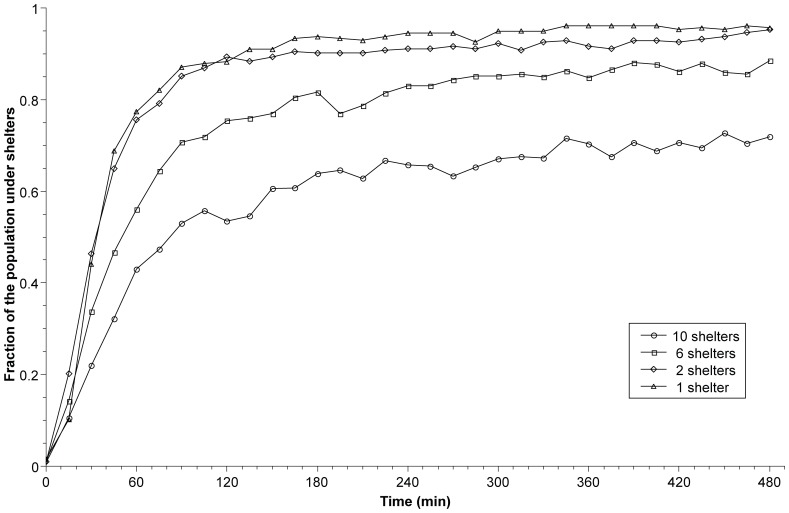
Dynamic of sheltering behavior.Change over time (min) of the mean fraction of cockroaches under shelters for groups confronted with a choice between 1 (n = 16, triangles), 2 (n = 21, diamonds), 6 (n = 21, squares), or 10 identical shelters (n = 32, circles).